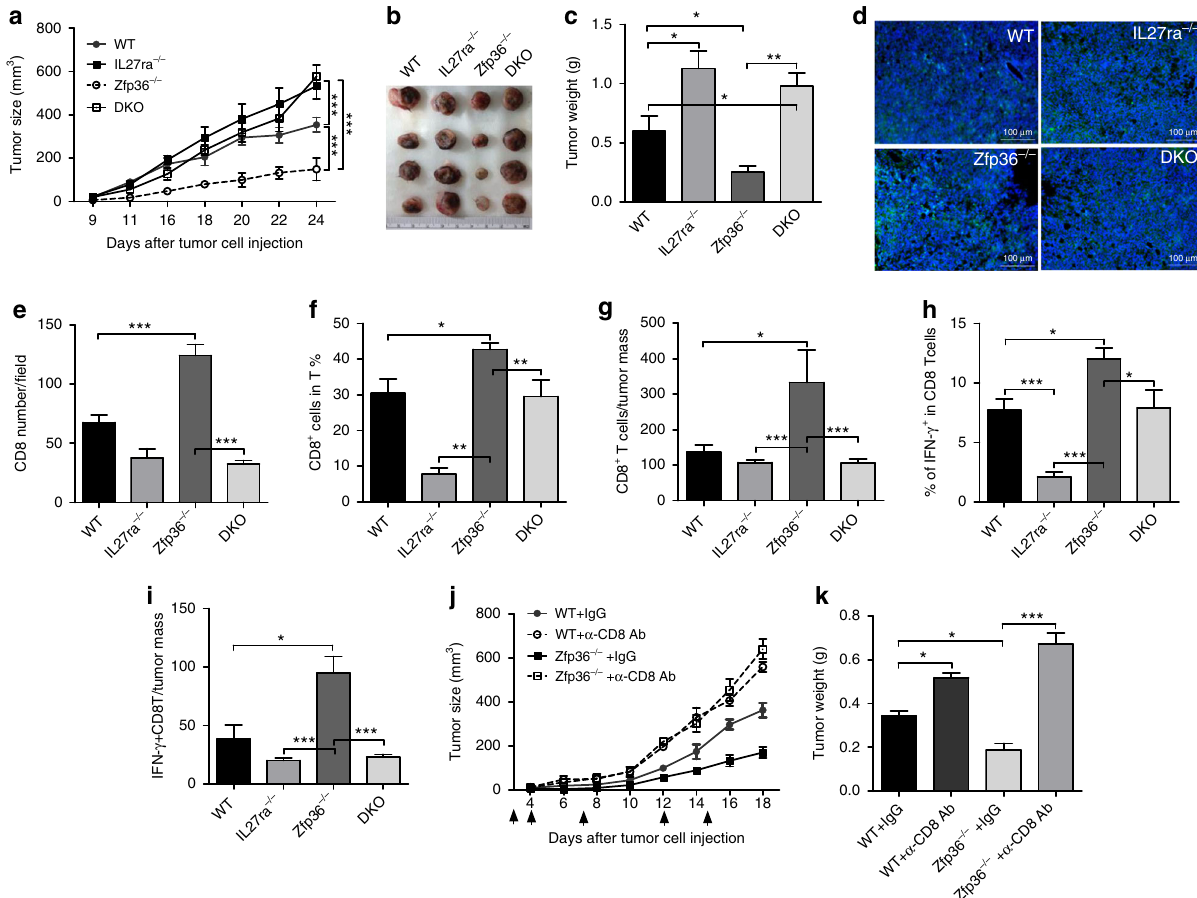
Fig. 6 TTP drives tumor progression by inhibiting IL-27 production and CTL function. a EO771 cells were inoculated into mammary pads of female WT, IL27ra − / − , Zfp36 − / − and DKO mice aged 6 – 8 weeks old. Tumor size was measured in three dimensions. Each group has four mice. b , c Mice were killed 24 days after tumor cell inoculation; tumors were imaged, weighted, and shown as means ± s.d. (four tumors in each group). d Tumor tissue sections were sainted with rat anti-CD8 antibody, AF488-labeled anti-rat IgG (1:200, green ), and diaminidophenylindol (DAPI, 1:200, blue). The images were taken by fl uorescence microscopy (magni fi cation: 100×). Rat IgG was used as negative control. e The numbers of CD8 + cells as in d were counted per fi eld on fi ve different sections of each tumor and summarized as means ± s.d ( n = 4). f The percentages of CD8 + T-cells in tumor homogenates were detected by FACS, gated on CD3 + CD8 + double positive cells ( n = 4). g The numbers of CD8 + T-cells per tumor weight were calculated and presented as CD8 numbers per gram of tumors ( n = 4). h The percentages of IFN- γ + cells in tumor homogenates were determined by FACS, gated on CD3 + CD8 + double positive cells ( n = 4). i The numbers of IFN- γ + CD8 + T-cells per tumor weight were calculated and presented as the numbers per gram of tumors ( n = 4). j EO771 cells were inoculated into mammary pads of eight female WT and Zfp36 − / − mice. Half of WT and Zfp36 − / − mice were treated by giving CD8 depletion antibody (150 μ g/mouse, InVivo MAb anti-mouse CD8 α ) or control IgG i . p at 0, 4, 7, 12 and 15 day after tumor cell inoculation for fi ve times in total (indicated as ↑ ). Tumor sizes were measured in three dimensions. Each group has four mice. k Mice were sacri fi ced 18 days after tumor cell inoculation, and tumors were taken out and weighted g . Data shown are means ± s.d. with four tumors in each group. All data were analyzed with One-way ANOVA (Nonparametric) with Turkey (Compare all pairs of columns), * p < 0.05; ** p < 0.01; *** p < 0.001 between indicated